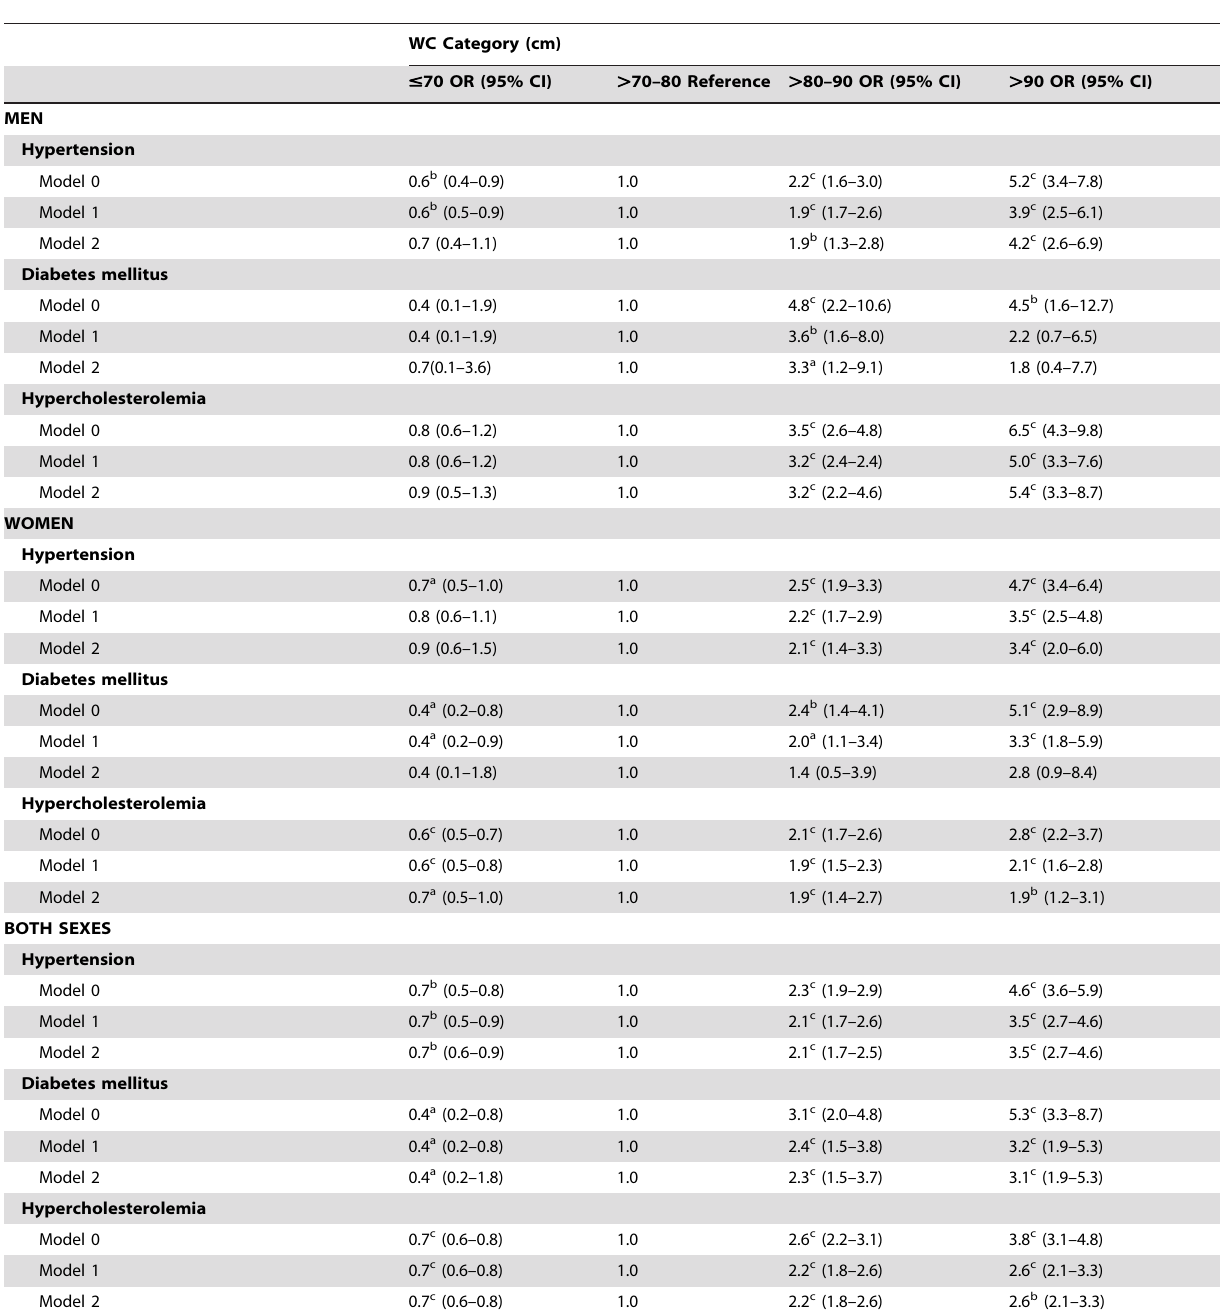
Table 4. Odd ratio (OR) of diabetes mellitus, hypertension and hypercholesterolemia across waist circumference (WC)